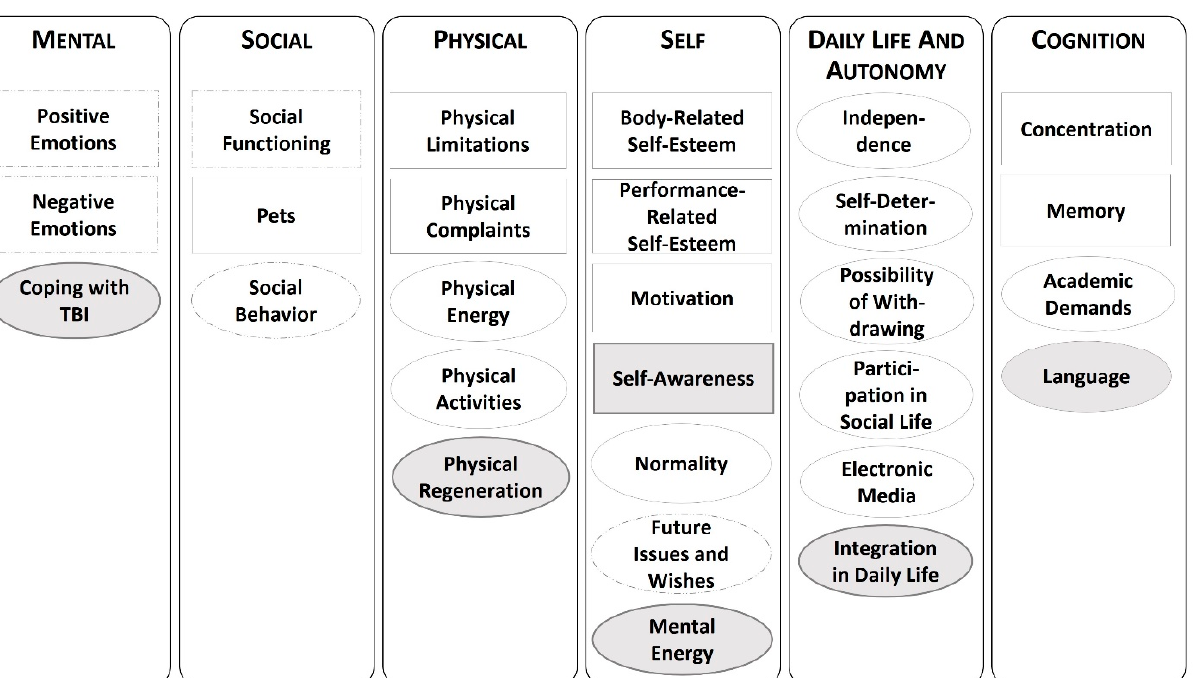
Table 1. Demographic characteristics of participants.